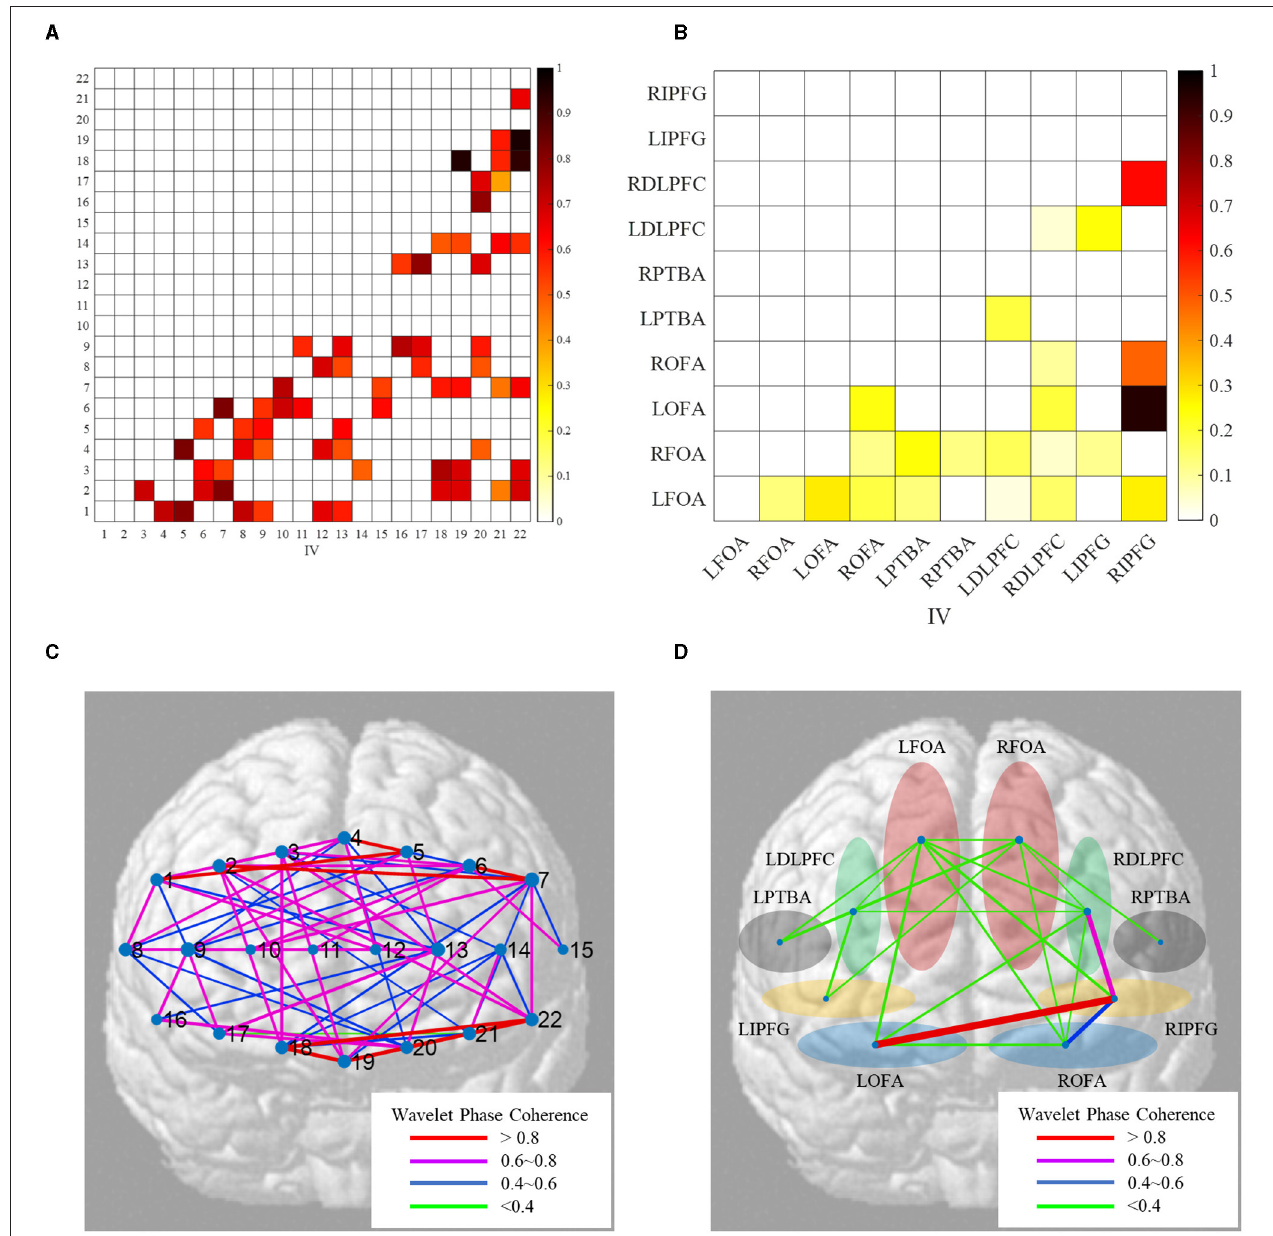
FIGURE 6 | Heatmaps of wavelet phase coherence and functional brain network of ROIs (subject #12). (A) Heatmaps of WPCO between channels; (B) heatmaps of WPCO between ROIs; (C) map of the functional brain network between channels; (D) map of the functional brain network between